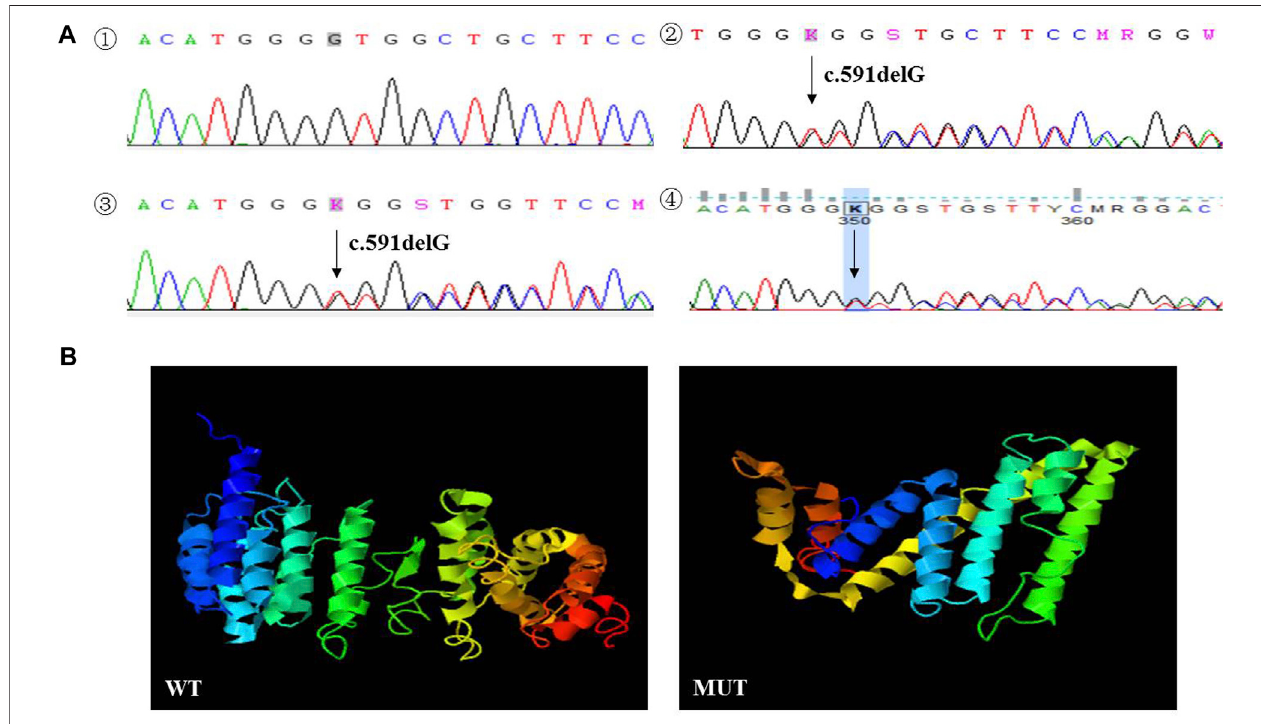
FIGURE 4 | (A) Sanger sequencing results of the proband and her family members. The deletion mutation (p. W198fs) in TINF2 gene was con fi rmed by Sanger sequencingperformedonperipheralbloodintheproband(2).Themother(3)andbrother(4)oftheprobandwerebothcarriedwiththismutation. TINF2 geneofthefather of the proband was wild-type (1). (B) Protein structure predicted by I-TASSER: the TINF2 p. W198fs mutation changed the tertiary structure of the